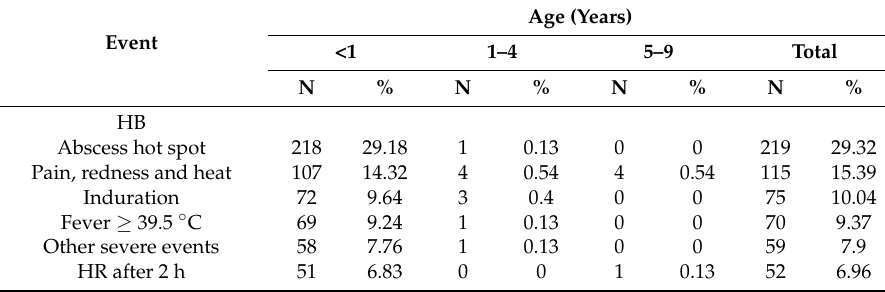
Table 2. Frequency of occurrence of the 10 most reported adverse events related to the injectable vaccines by age groups, considering only single inoculation